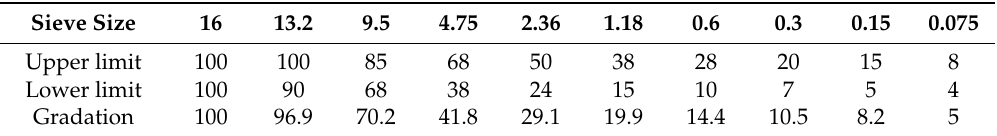
Table 5. Gradation AC13 asphalt mixture.